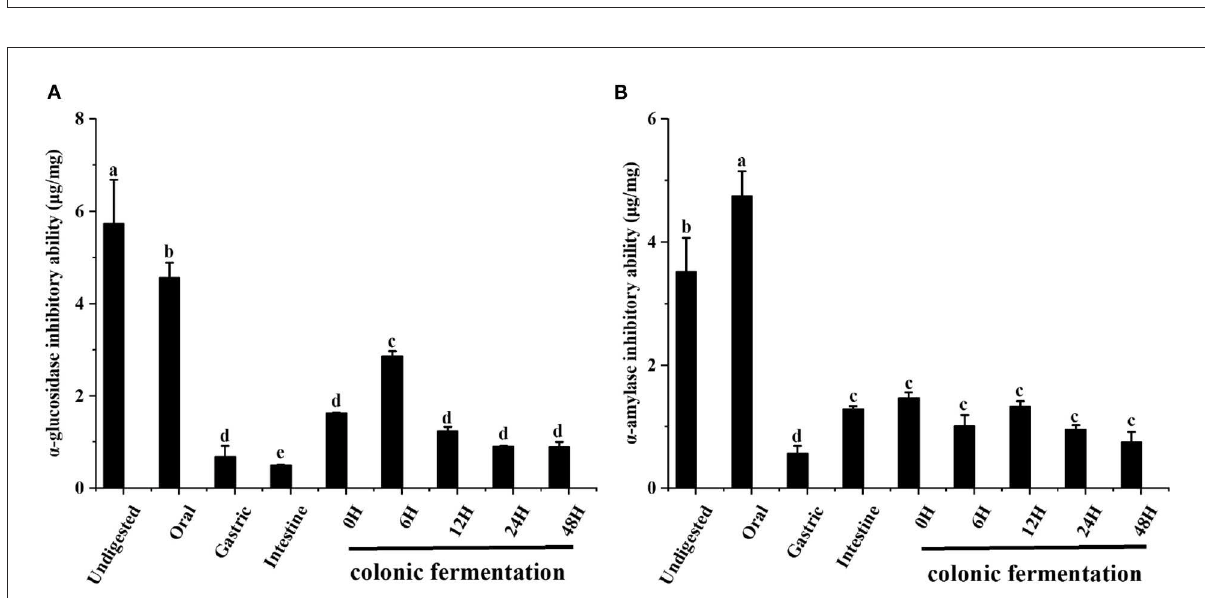
FIGURE4 The α -glucosidase and α -amylase inhibitory abilities of FJR in simulated digestion colonic fermentation stage in vitro . (A) α -glucosidase inhibitory ability. (B) α -amylase inhibitory ability. Different letters (a–e) mean significant difference ( p <